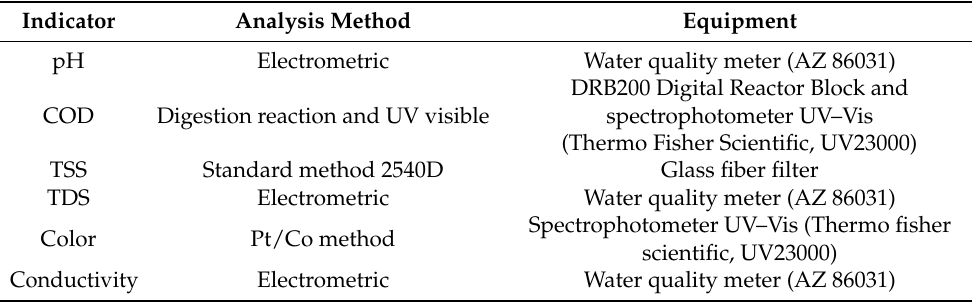
Table 1. Analytical methods and equipment used for water quality indicator measurements.